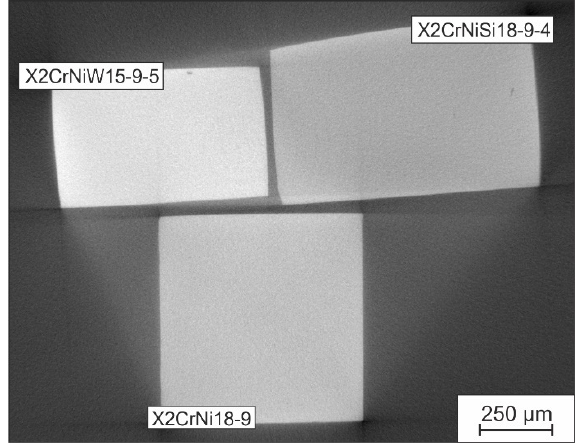
Figure 8. CT slices of the steels: ( a ) X2CrNiW15 ‐ 9 ‐ 5; ( b ) X2CrNiSi18 ‐ 9 ‐ 4. Blue circles highlight the non ‐ metallic inclusions. The red boxes contain SEM images of each steel’s microstructure for comparison.